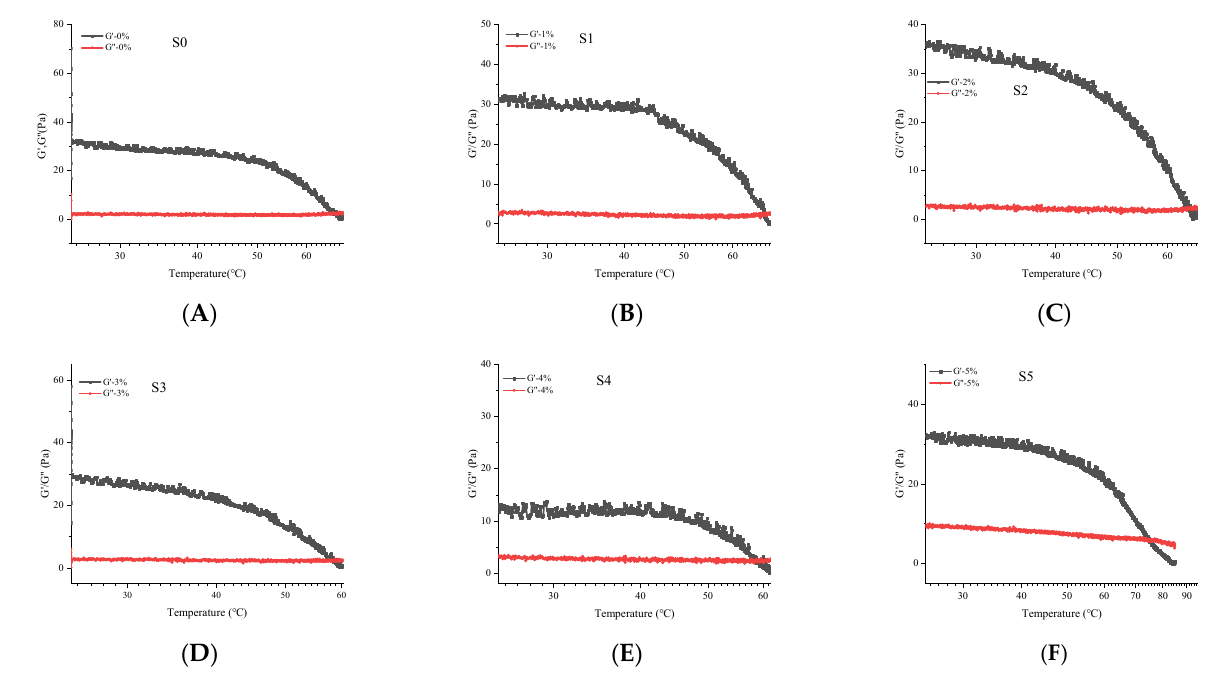
Figure 3. The storage modulus (G ′ ) and loss modulus (G ′′ ) of S0–S5 as a function of temperature at the frequency of 1 Hz. ( A ) S0; ( B ) S1; ( C ) S2; ( D ) S3; ( E ) S4; ( F ) S5. The ratios of gellan gum and soybean isolate were S0 (0.3:0); S1 (0.3:1); S2 (0.3:2); S3 (0.3:3); S4 (0.3:4); S5 (0.3:5).